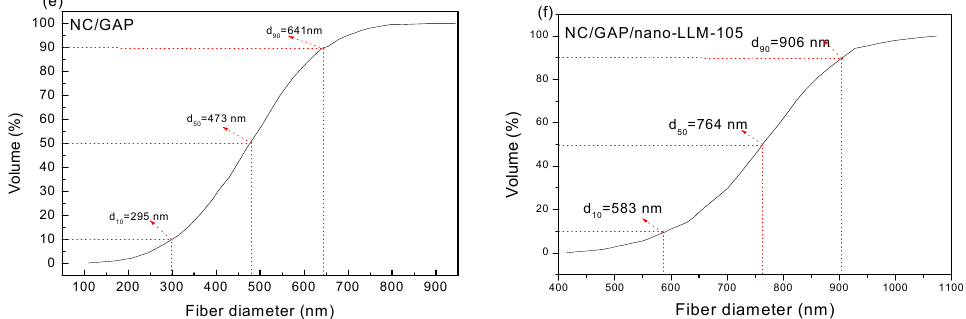
Figure 3. Images and diameter distributions of samples: ( a ) for NC/GAP; ( b ) for Figure3. Imagesanddiameterdistributionsofsamples: ( a )forNC / GAP;( b )forNC / GAP / nano-LLM-105; NC/GAP/nano-LLM-105; ( c–f ) the diameter distribution. ( c–f ) the diameter distribution. NC/GAP/nano-LLM-105; ( c–f ) the diameter distribution.